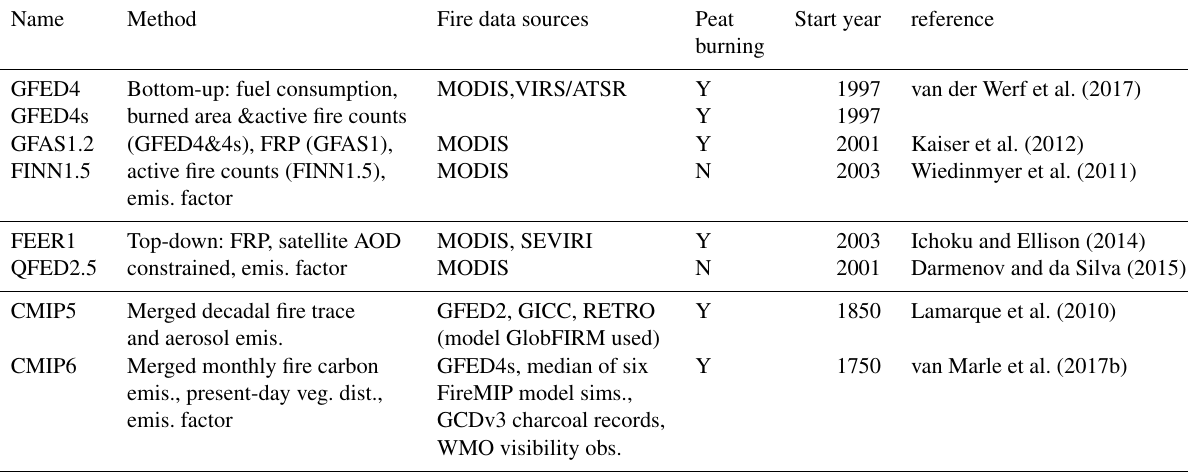
Table 5. Summary description of satellite-based products and historical constructions merged from multiple sources.